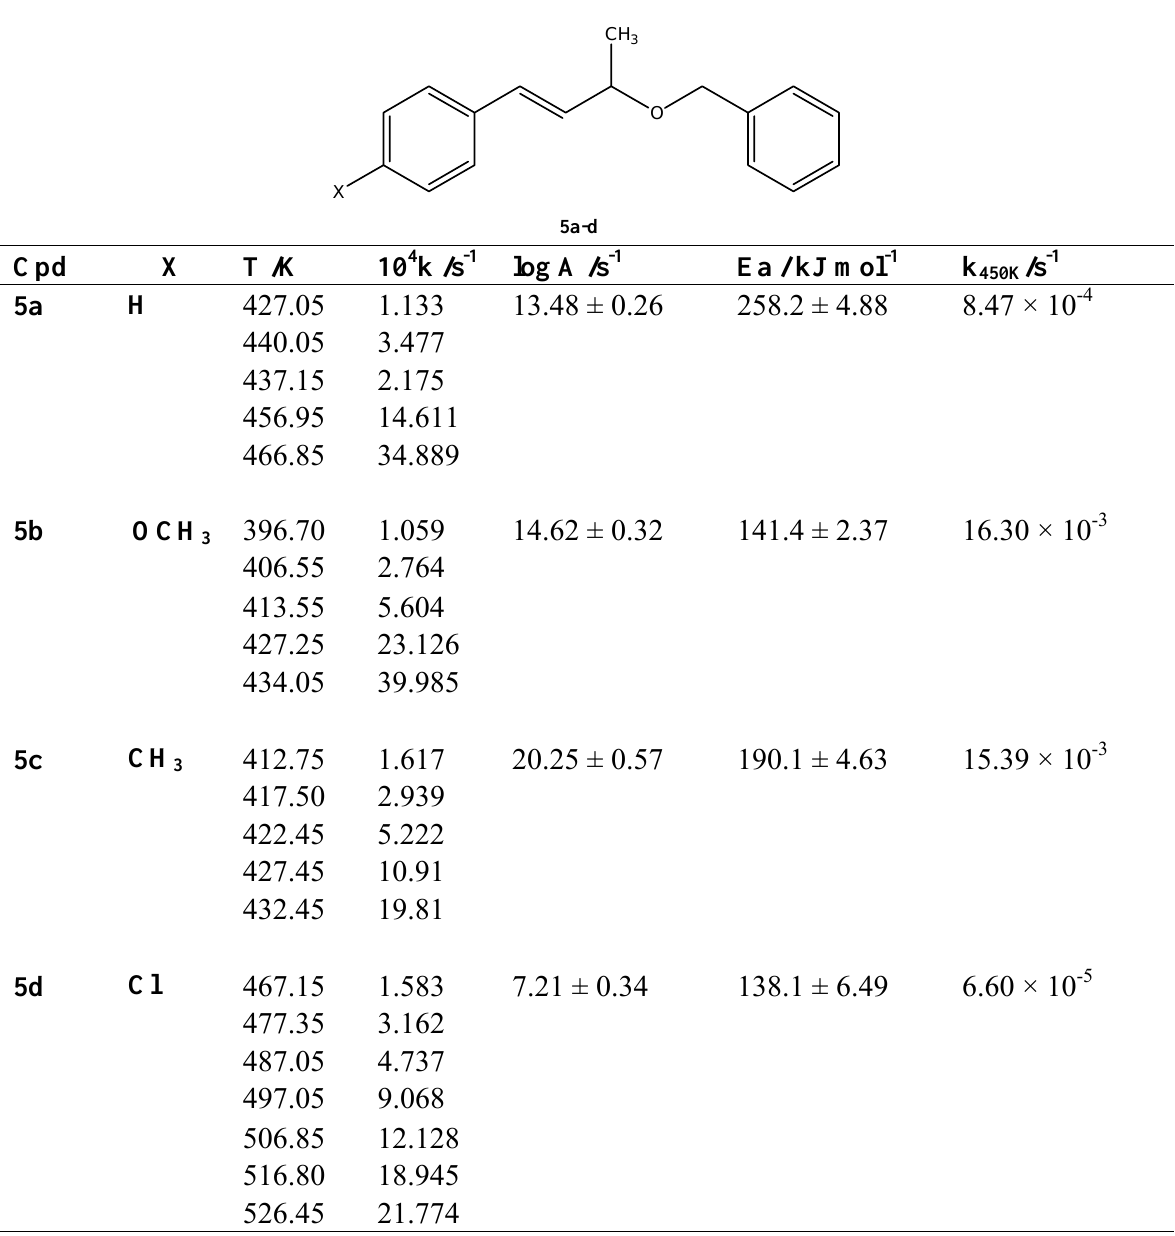
Table 3. Rate coefficient (k/s -1 ), Arrhenius parameters of compounds